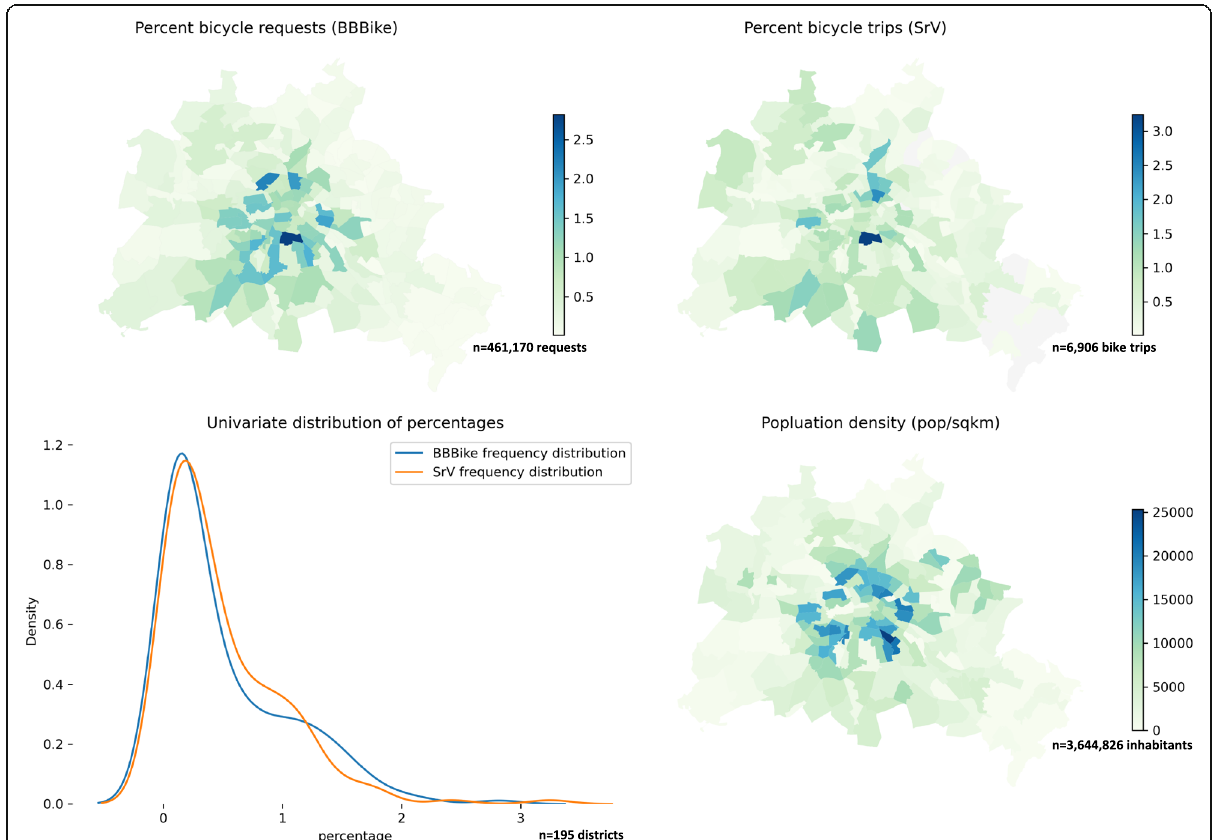
Fig. 8 Spatial distribution of the proportion of BBBike requests in a certain district in regard to all requests (top left), the proportion of SrV trips starting in a certain district in regard to all trips (top right),), frequency distribution of percentages of BBBike and SrV across all districts (bottom left) and population density (bottom